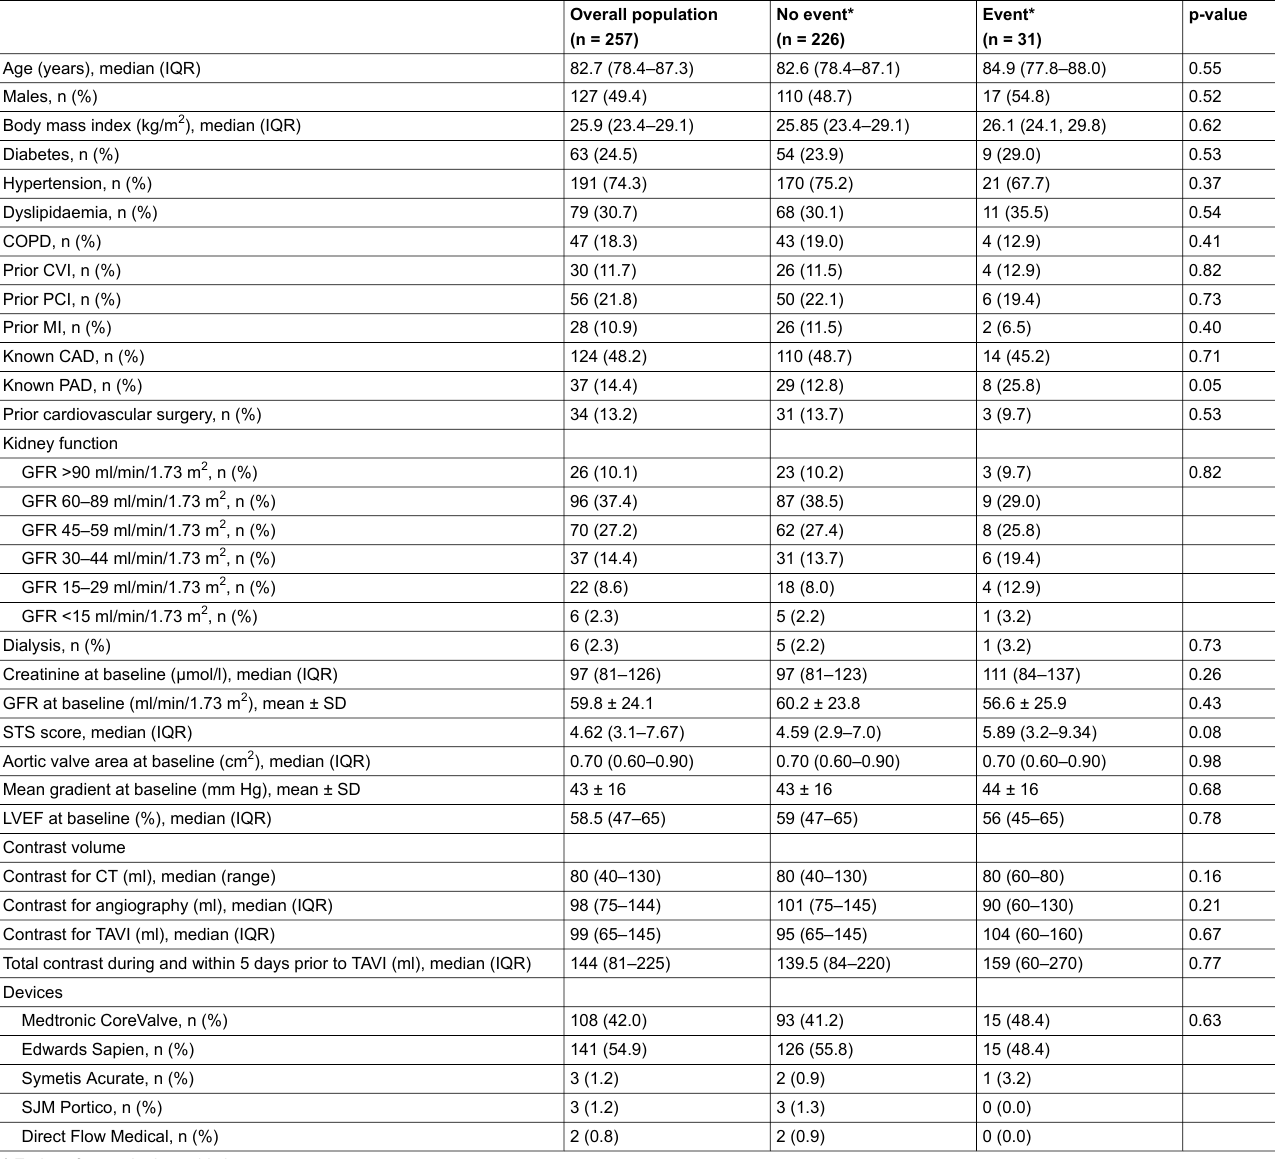
Table 1a: Patient characteristics according to the early safety endpoint.